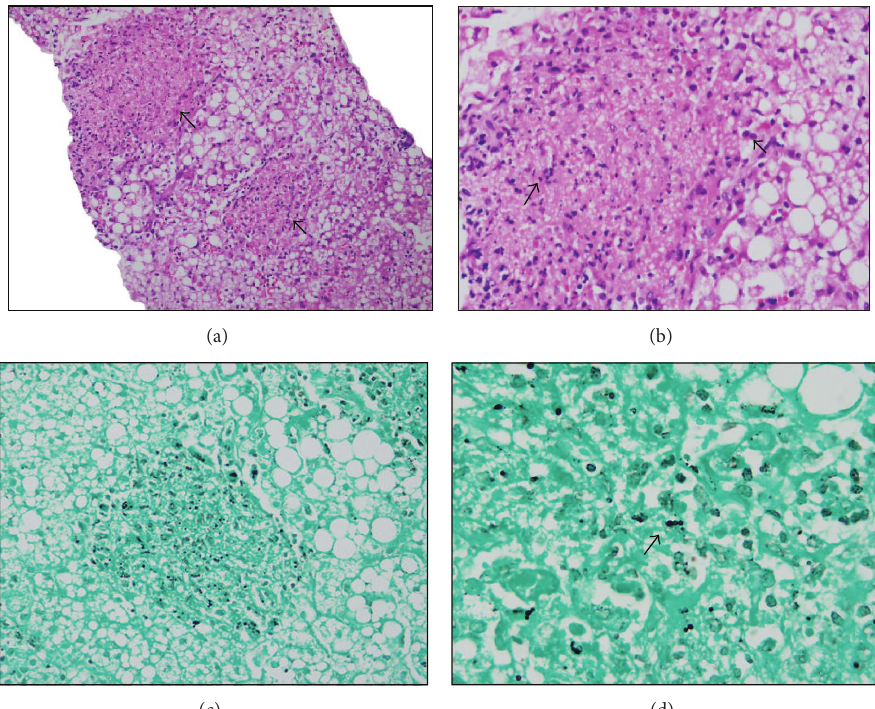
Figure 1: (a) HE × 20, presenting two granulomas (arrows) and (b) HE × 40, showing inflammatory infiltrate and clusters forming numerous microabscesses, abundant polymorphonuclear neutrophils, cellular debris, histiocytes, epithelioid cells, and necrosis. (c) G¨om¨ori × 20 and (d) G¨om¨ori × 40, revealing blastoconidia formations (arrows), morphologically consistent with Histoplasma